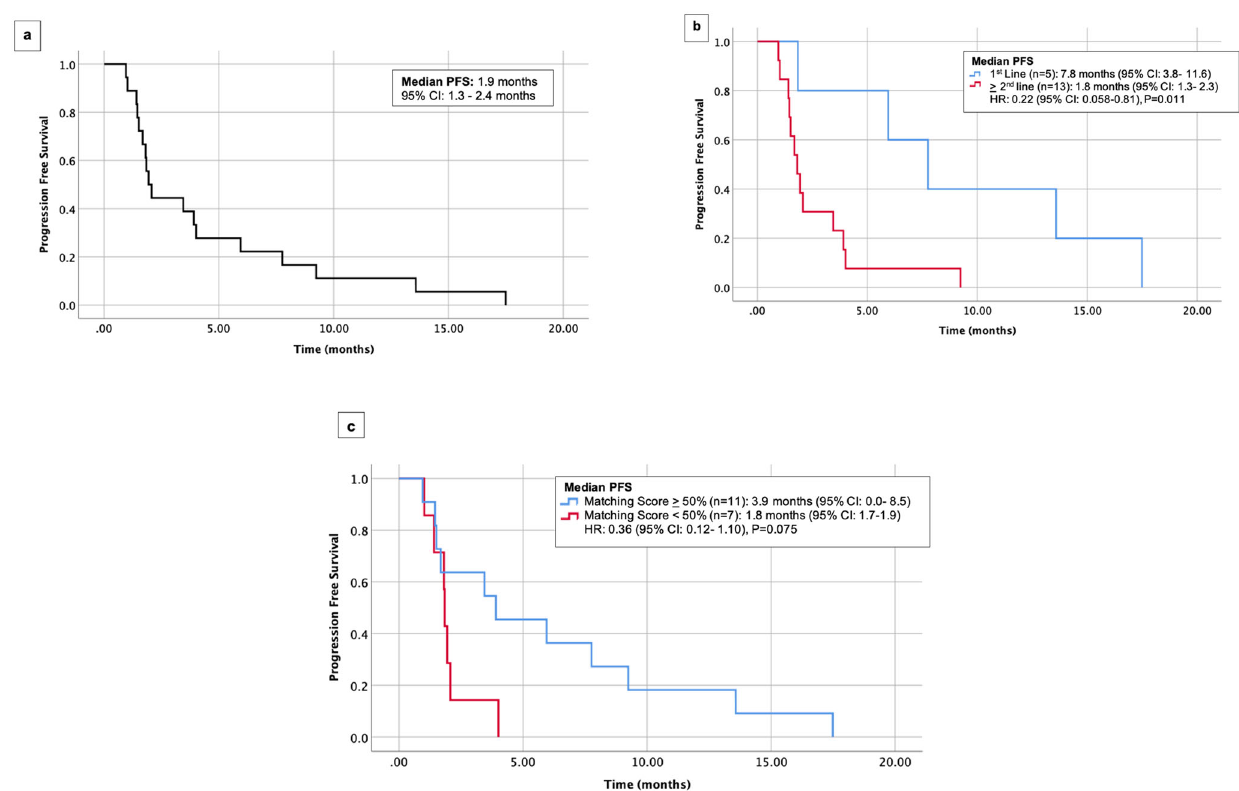
Fig. 1 Progression-free survival (PFS) among 18 patients with pancreatic cancer who received matched therapy. a PFS in 18 patients. b PFS in 5 patients who received targeted therapy as fi rst line versus 13 patients who received it as ≥ 2nd line. c PFS in 11 patients with matching score ≥ 50% versus 7 patients with matching score <50%. CI con fi dence interval, PFS progression-free